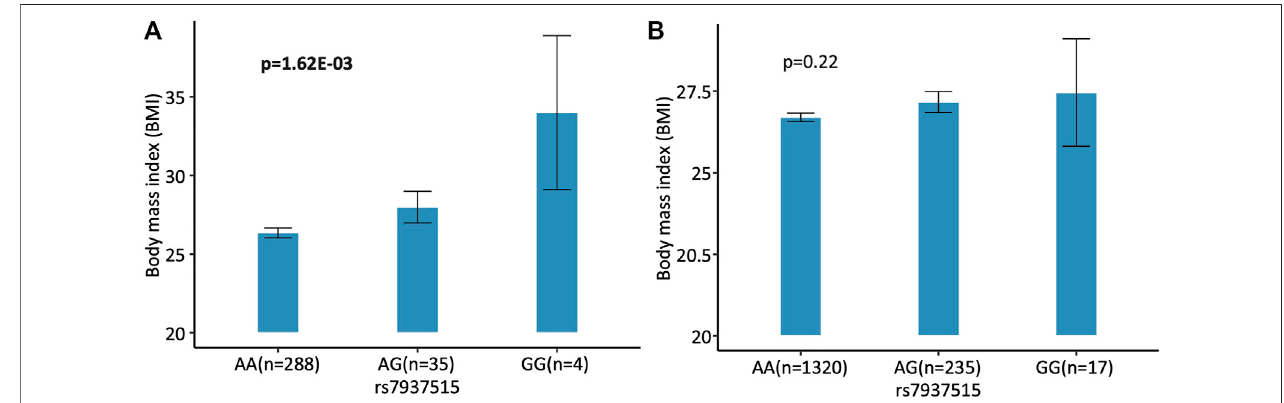
FIGURE 4 | Association of rs7937515 on BMI in the HCP and ADNI cohorts. (A) Mean BMI with standard errors are plotted against the rs7937515 genotype groups (i.e., AA, AG and GG) for the HCP cohort. (B) Mean BMI with standard errors are plotted against the rs7937515 genotype groups (i.e., AA, AG and GG) for the ADNI cohort. p values are calculated from mediation analysis, and signi fi cant p values are marked in bold.